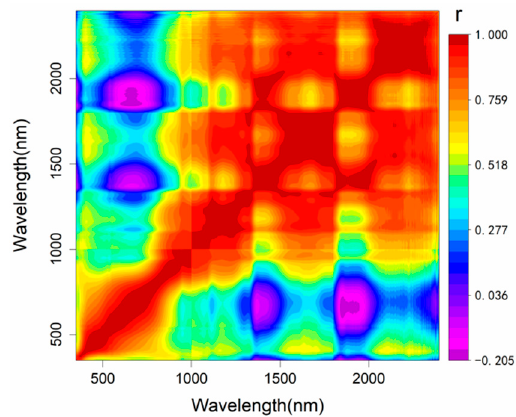
Figure 4. 2-D correlation spectra of wavelength variables.